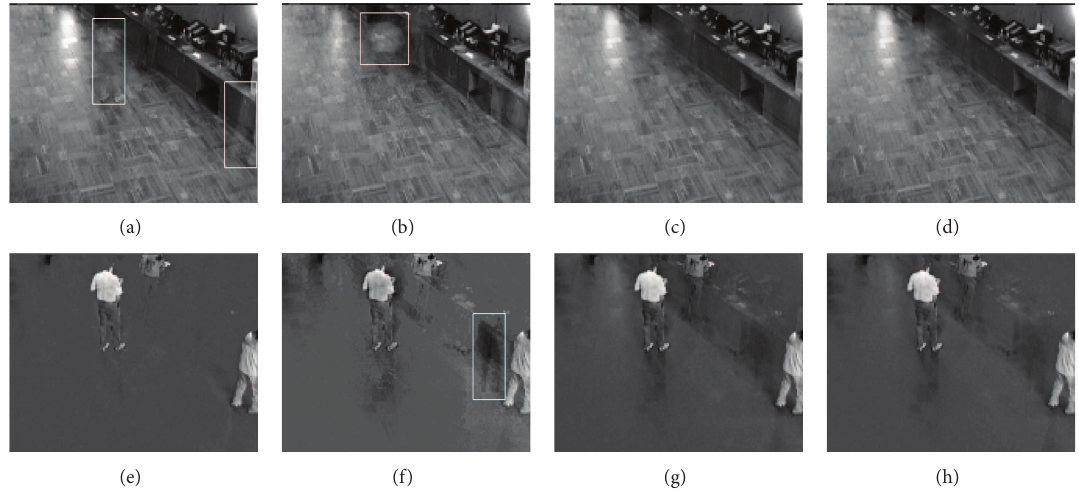
Figure 5: Restaurant: (a)–(d) background and (e)–(h) foreground from IALM, GoDec, NSMP, and WNSMP.